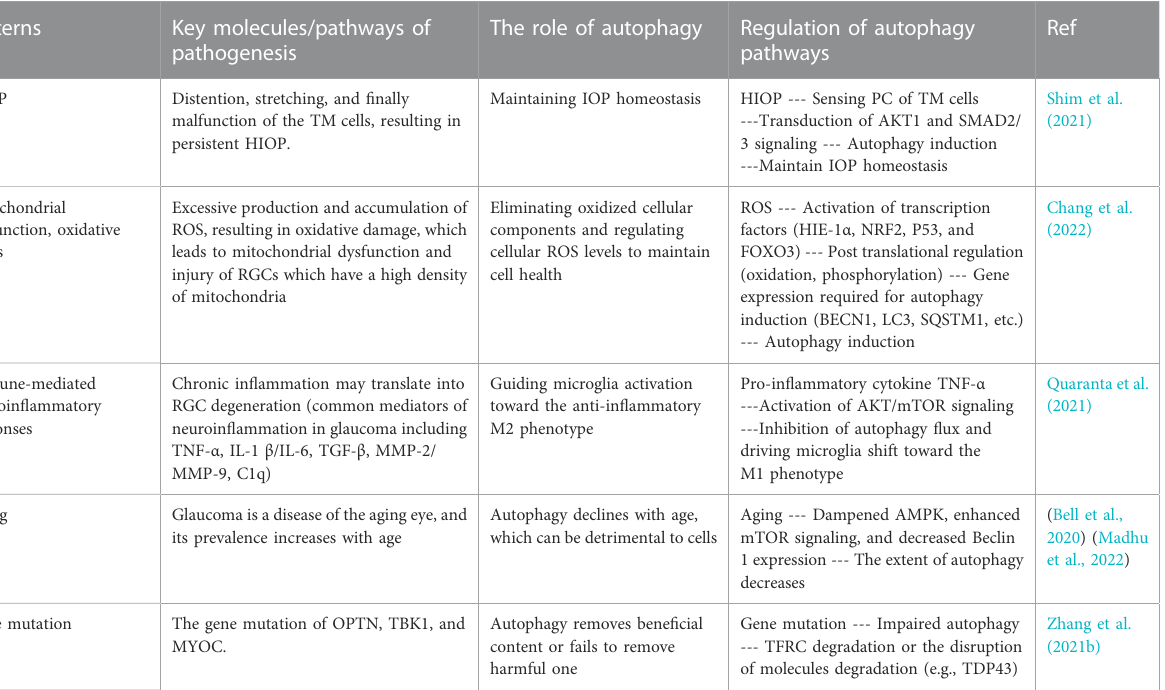
TABLE 1 Glaucoma pathogenesis and autophagy